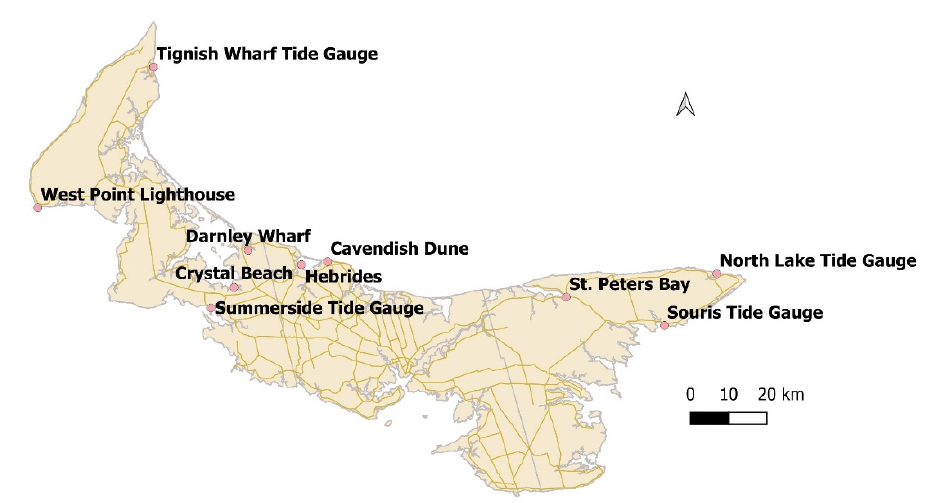
Figure 7. Select Dorian impact locations mentioned in the text.